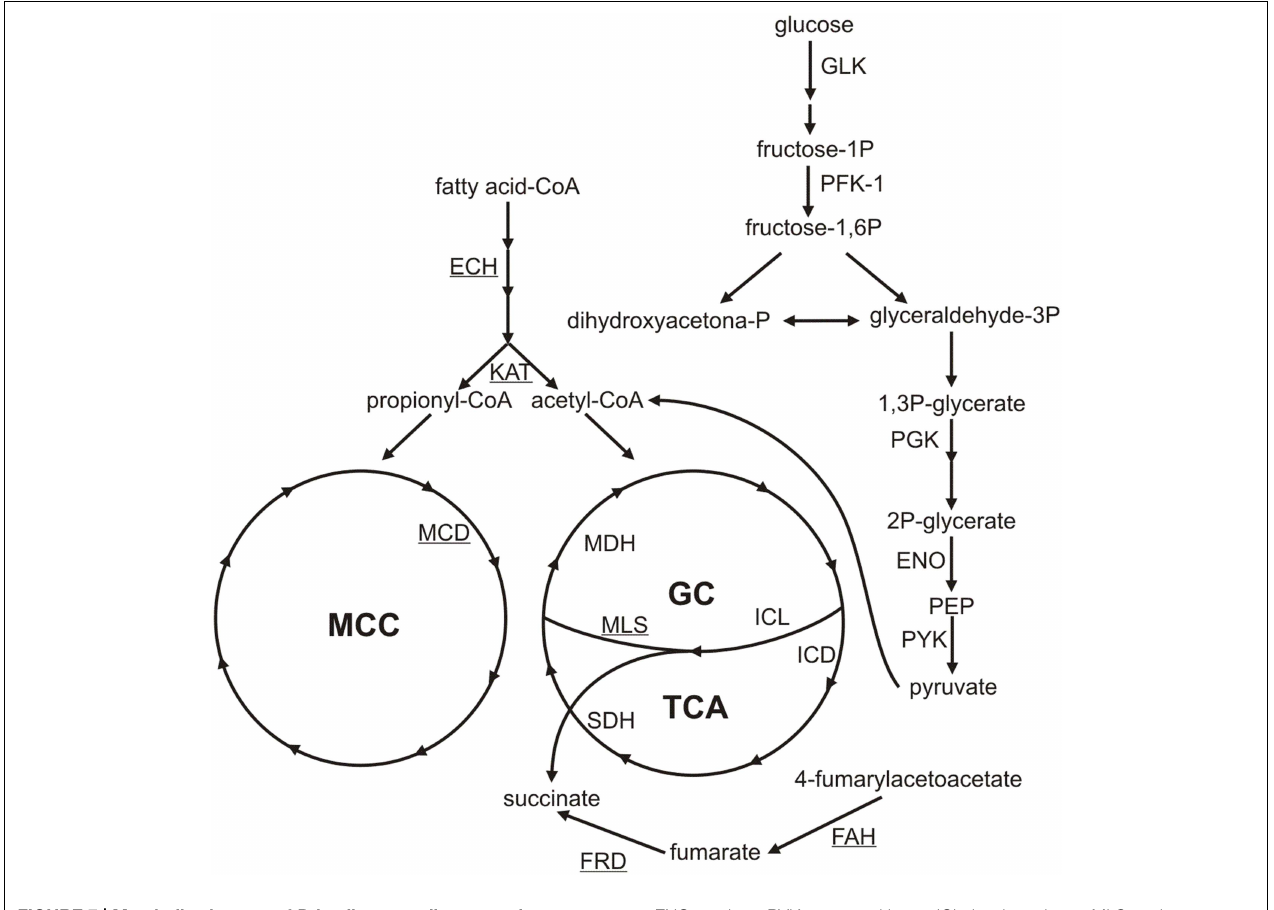
FIGURE 7 | Metabolic changes of P. lutzii yeast cells exposed to argentilactone. The less abundant proteins during treatment are not highlighted. The more abundant proteins are underlined. GC, glyoxylate cycle; TCA, tricarboxylic acid cycle; MCC, methylcitrate cycle; GLK, glucokinase; PFK-1, phosphofructokinase-1; PGK, phosphoglycerate kinase;